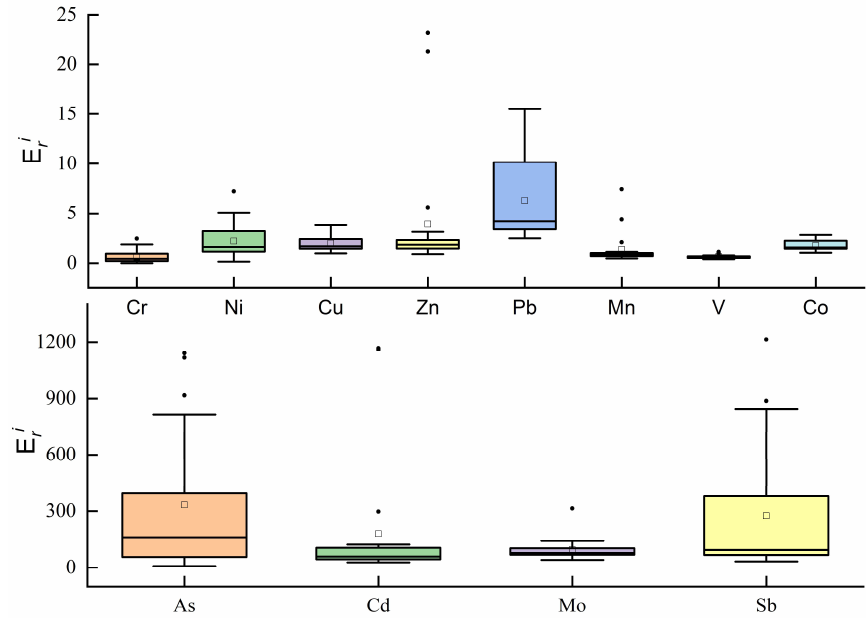
Figure 4. Boxplots of individual potential ecological risks of heavy metals in surface sediments.